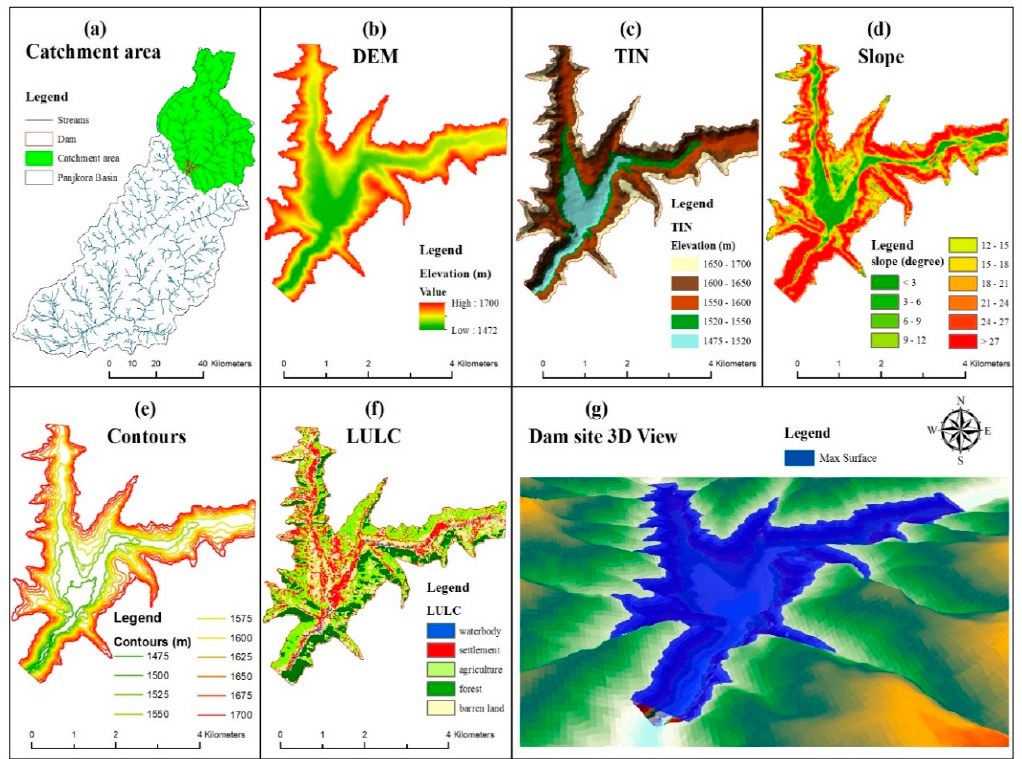
Figure 14. Evaluation parameters for Dam site 2: ( a ) catchment area ( b ) elevation ( c ) TIN ( d ) slope ( e ) contours ( f ) LULC ( g ) 3D view.